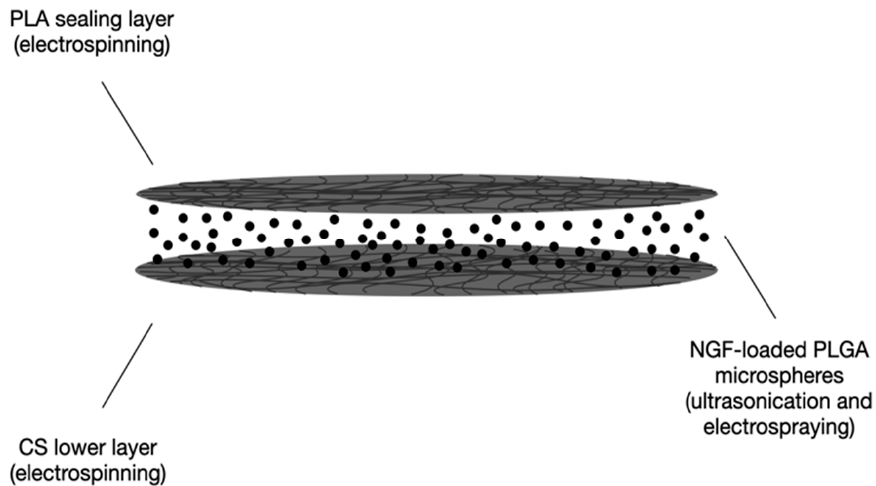
Figure 3. Schematic representation of the sandwich-structured drug delivery composite scaffold developed by Song and coworkers [41].